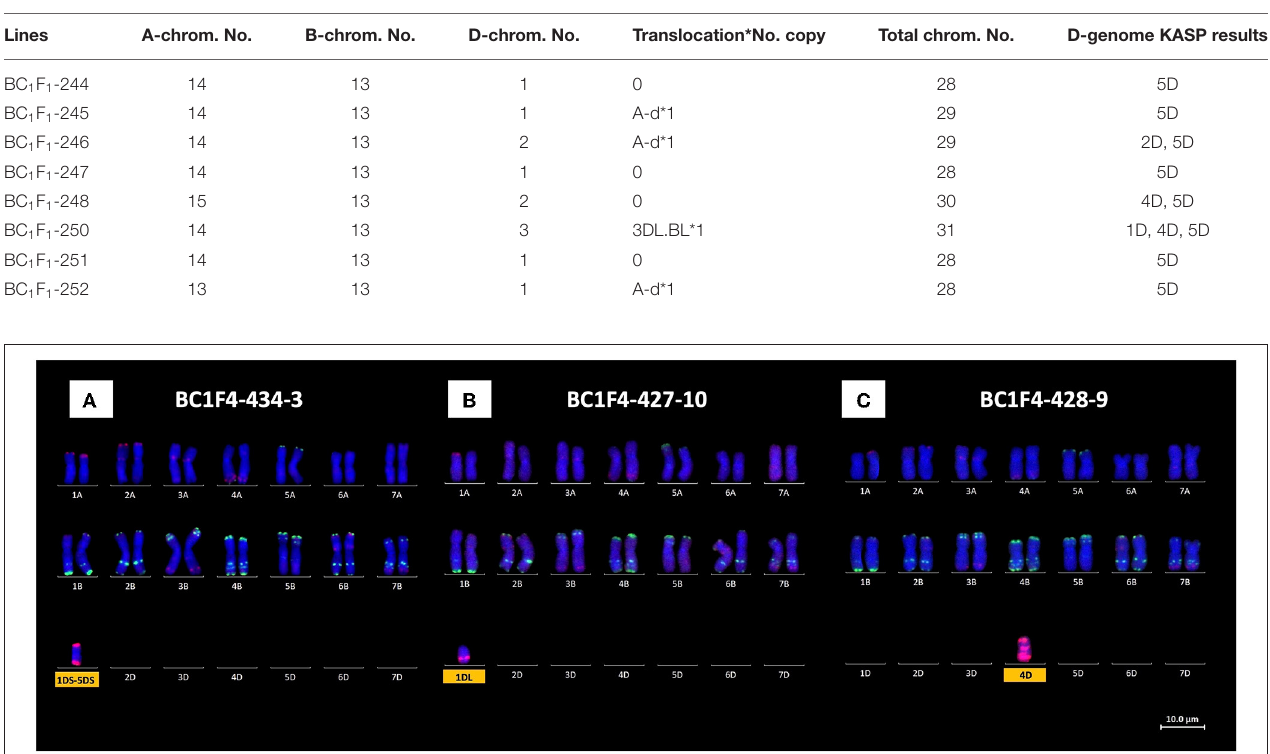
FIGURE 4 | Mc-FISH-based karyotype using the Oligo-pAs.1 (red) and Oligo-pSc119.2 (green) probes counterstained with DAPI (blue) of the (A) 1DS.5DS translocated chromosome, (B) 1DL chromosome arm, and (C) 4D-chromosome monosomic addition